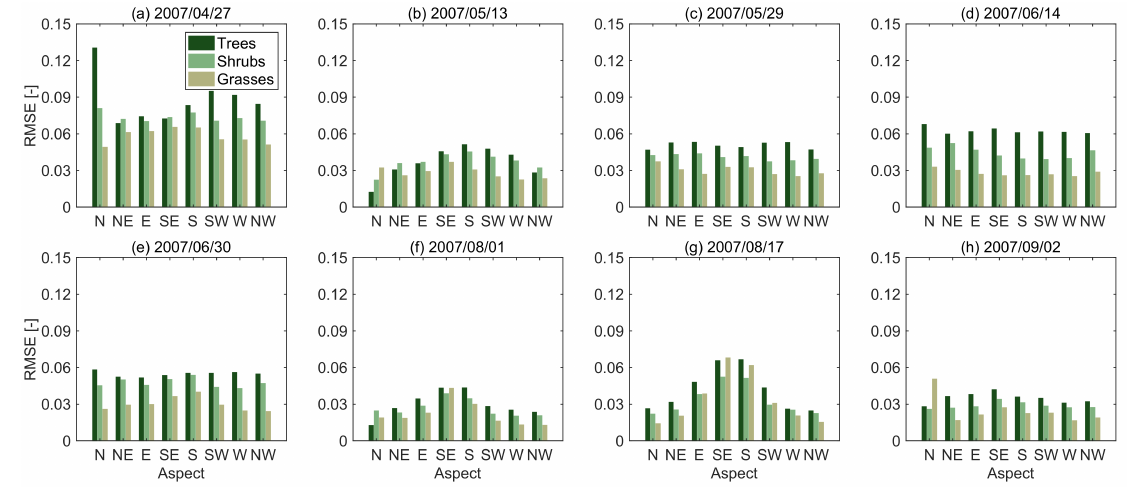
Figure 5. Root mean square error (RMSE) separated by dominant vegetation functional type and aspect over the 2007 growing season at Dry Creek Experimental Watershed (DCEW), Idaho, USA for ( a ) 27 April 2007, ( b ) 13 May 2007, ( c ) 29 May 2007, ( d ) 14 June 2007, ( e ) 30 June 2007, ( f ) 1 August 2007, ( g ) 17 August 2007, and ( h ) 2 September